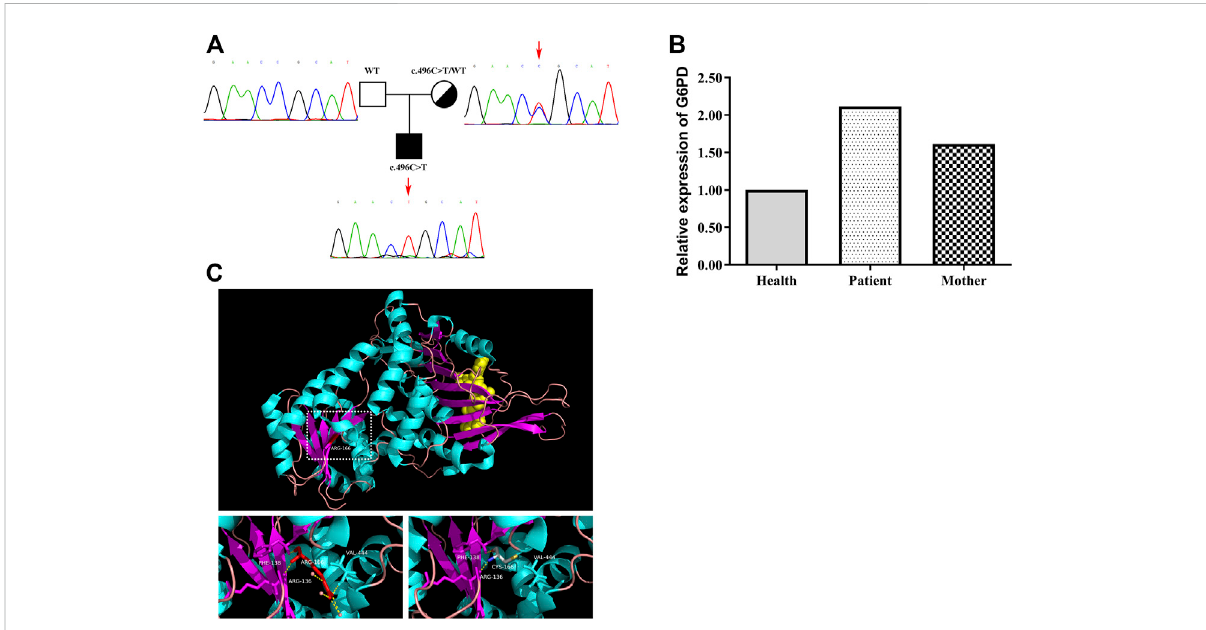
FIGURE 2 Gene analysis of the G6PD mutation in the patient and his mother. (A) Family tree and con fi rmation of mutation c.496 C > T in G6PD by Sanger sequencing. (B) LevelofG6PDmRNAinPBMCsderivedfromthehealthycontrol,thepatient andthemother.The mRNAlevel ofG6PD washigher in the patient than in the healthy control and mother. (C) Schematic model of WT and the mutated G6PD protein. The p. R166C mutant (right) might affect the hydrophobic binding of the amino acid residues to other nearby